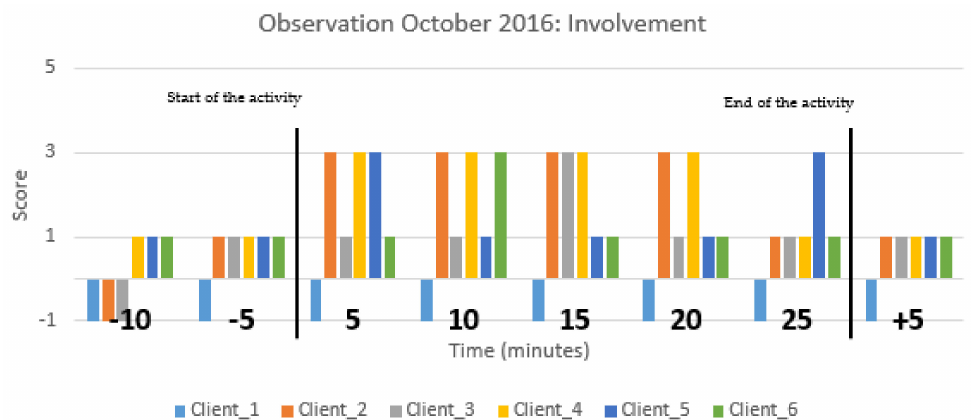
Figure 7. An observation score on involvement during a group activity with the Zora robot in which six clients participated. All clients are from a psychogeriatric ward. Each colored bar represents one client. On the X-axis, the time prior to an activity ( − 10 and − 5), the time during the activity (0–25) and the time after the activity (+5) are given. On the Y-axis, the involvement score ( − 1 to + 5) is given. The black vertical lines mark the start and end of the group activity with